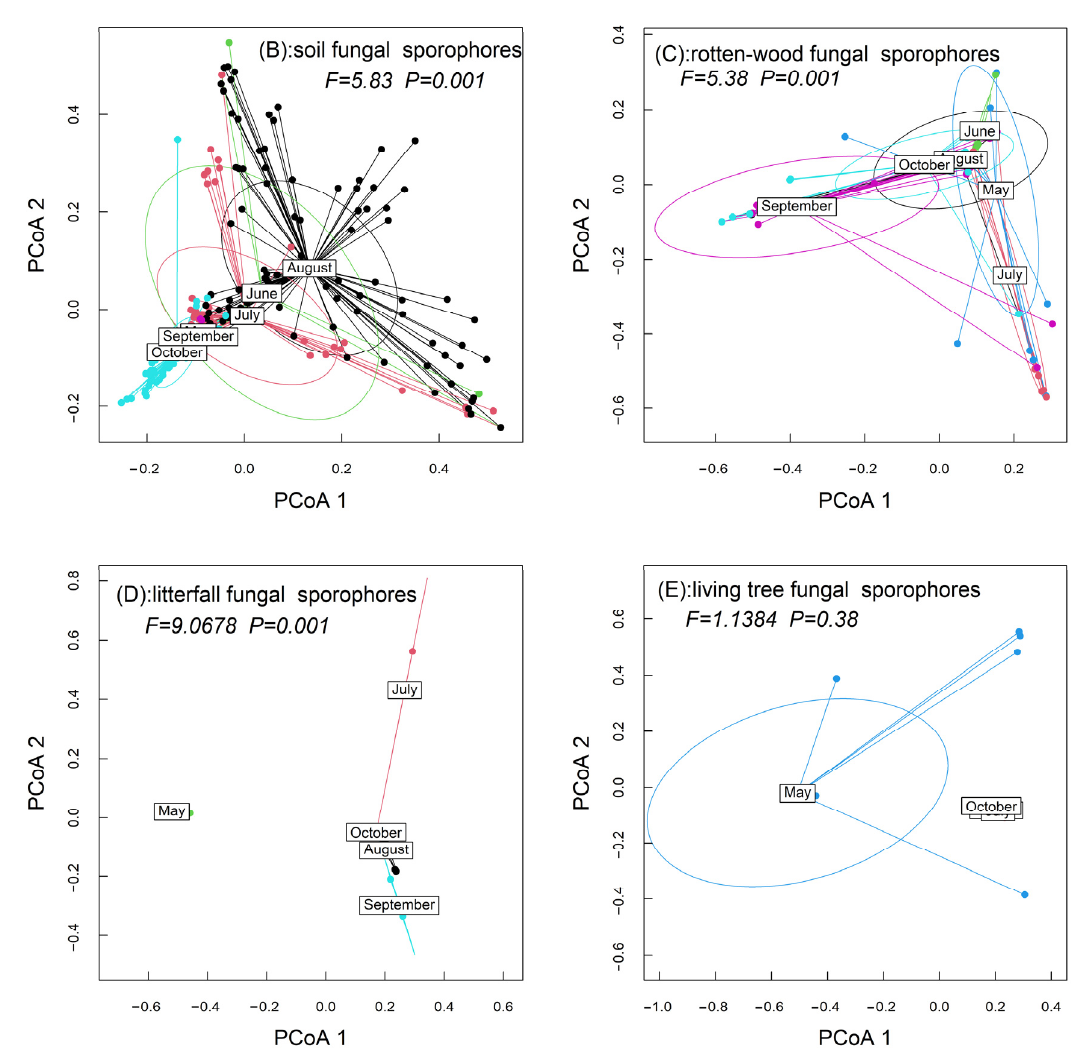
Figure 2. Effect of months on beta diversity of the fungal sporocarps by PCoA. PERMANOVA was applied to test how these distances differed among months. Capital “ F ” refers to F values, and capital “ P ” refers to p values. PCoA1 and PCoA2 are the first and second sort axes in the “PERMANOVA” analysis, respectively.